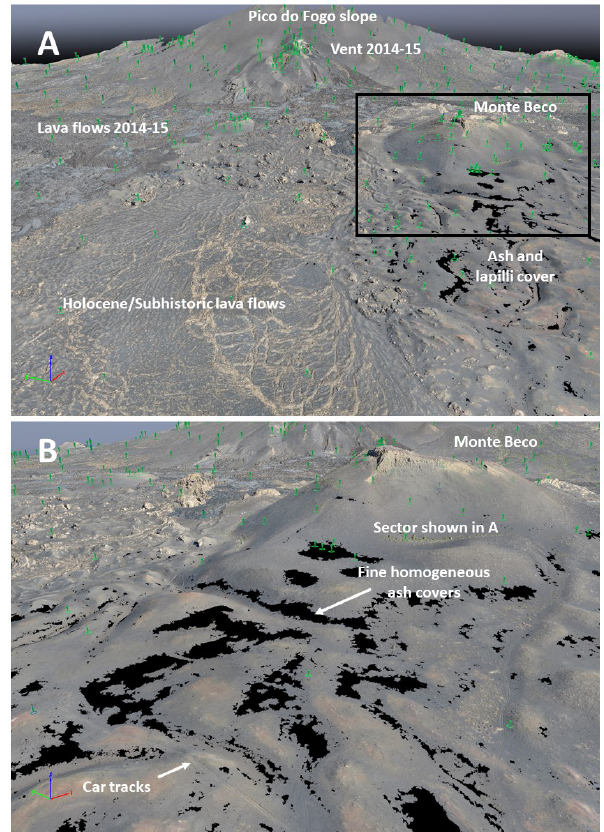
Figure 6. Examples of the quality of the 3D dense point cloud. (a) Most of the point cloud shows dense point coverage and high accuracy, with the figure showing the lava fields close to Monte Beco and the small areas with gaps and low quality. (b) Low-quality areas in ash surfaces close to Monte Beco (car tracks for scale). The green pins are manual tie points. The location of the sector covered in this figure is indicated in Fig.